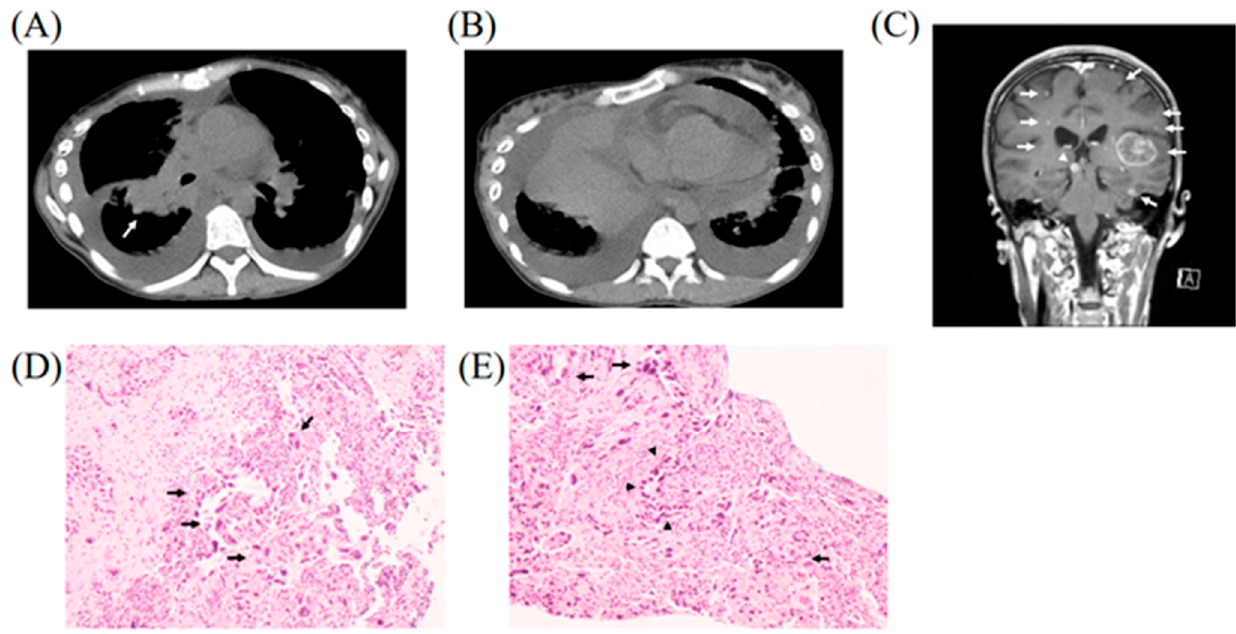
Figure 1. Chest computed tomography showed a mass in the right lower lobe (arrow) accompanied by hilar and mediastinal lymph nodes metastases ( A ), bilateral pleural effusions, and a pericardial effusion ( B ). Brain magnetic resonance imaging with contrast enhancement (coronal T1-weighted image) revealed multiple brain metastases in bilateral cerebral hemispheres (arrows) and right midbrain (arrowhead), with the largest metastasis in the left temporal lobe ( C ). Hematoxylin-eosin staining of the transbronchial biopsy specimen showed giant cell invasion (arrows) suggesting sarcomatoid carcinoma ( D , E ) as well as columnar and cylindrical structures (arrowheads) suggesting adenocarcinoma component ( E ). More than 10% of the cells in the specimen were giant cells ( D ). Osimertinib, a third-generation EGFR-TKI, was administered at a dose of 80 mg